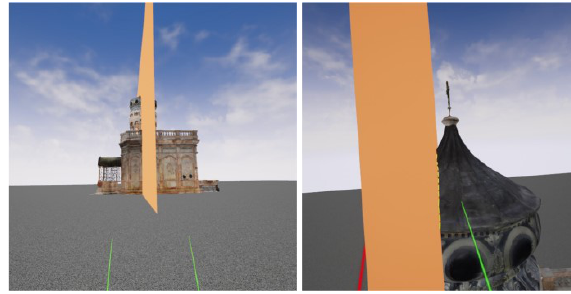
Figure 8 . A vertical plane of a section defined by the user